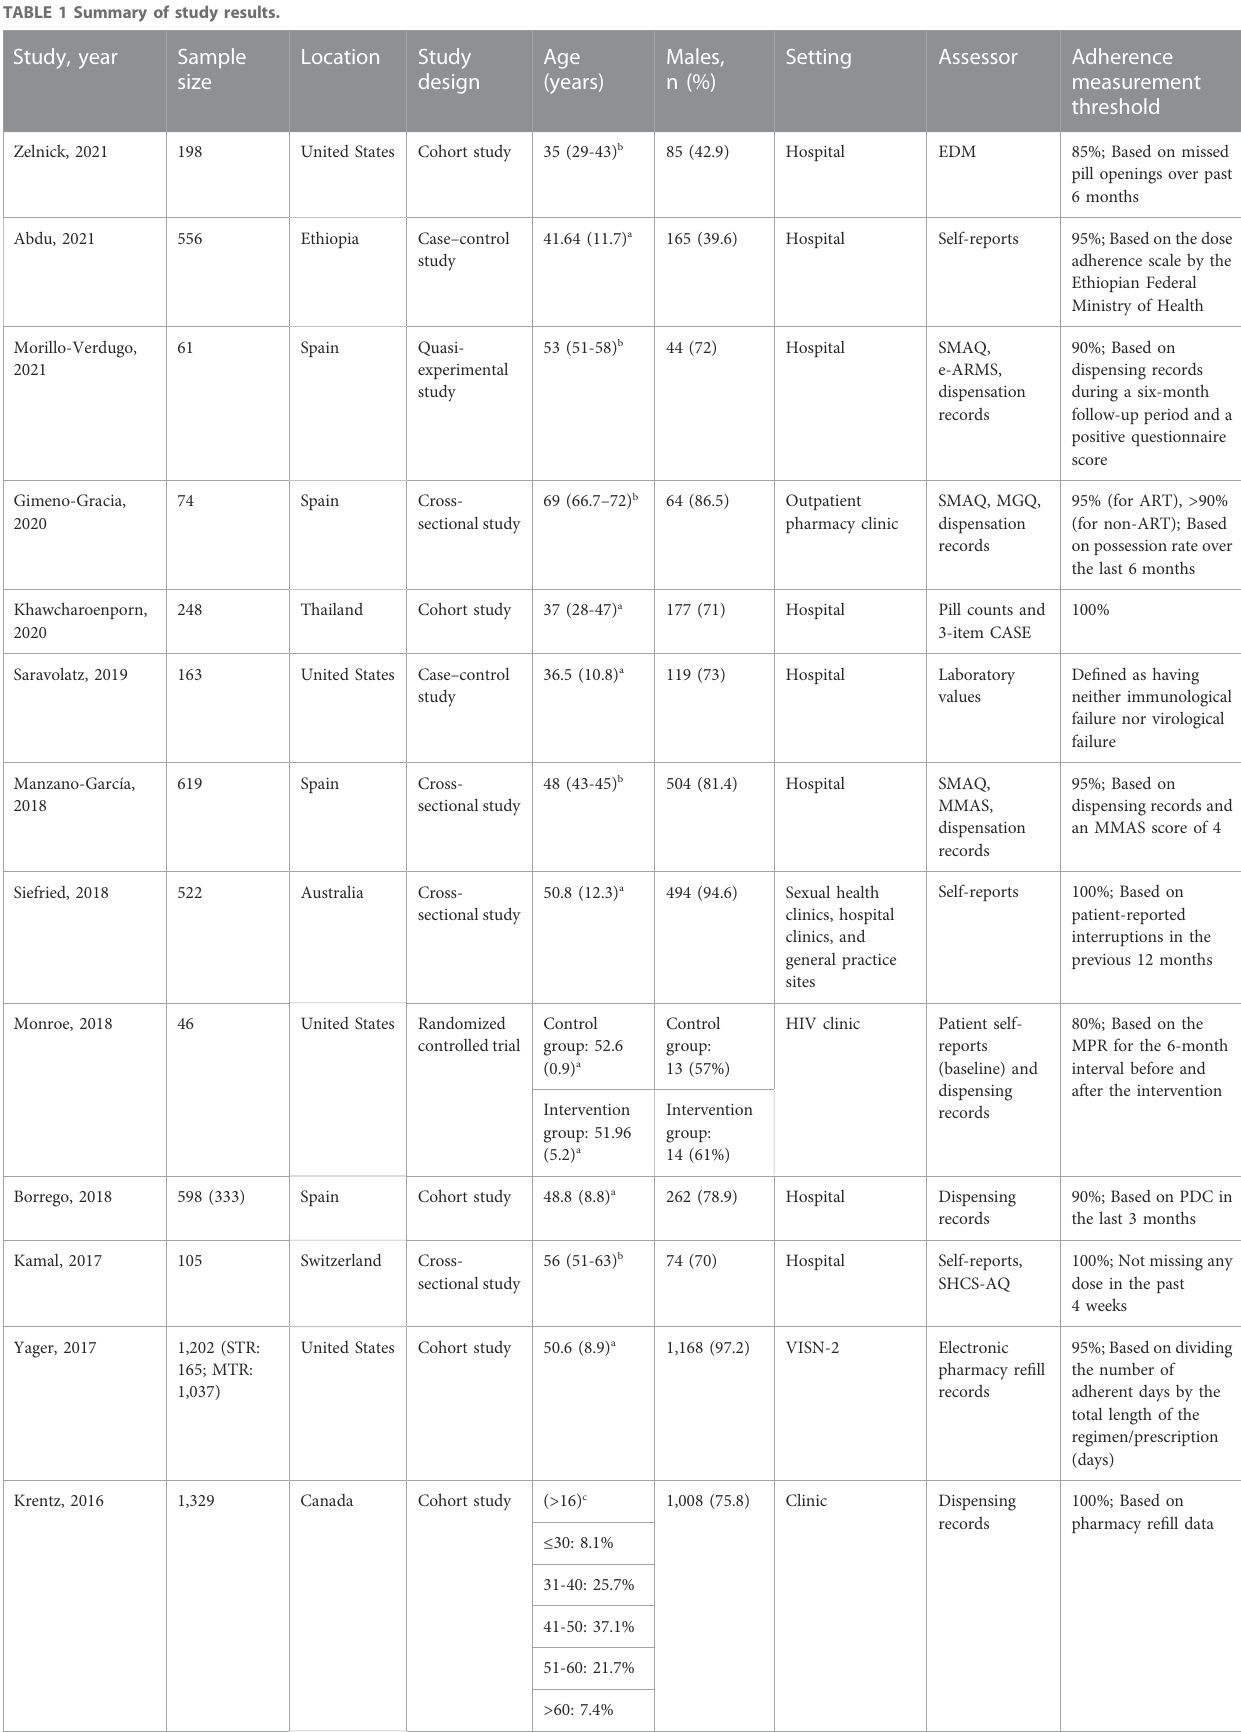
TABLE 1 Summary of study